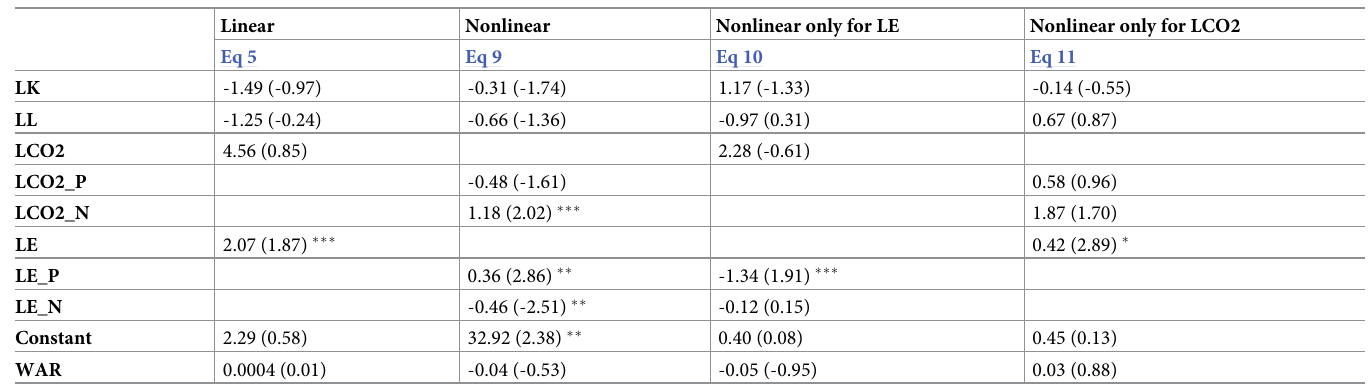
Table 3. Long-run coefficient estimates of linear and nonlinear ARDL